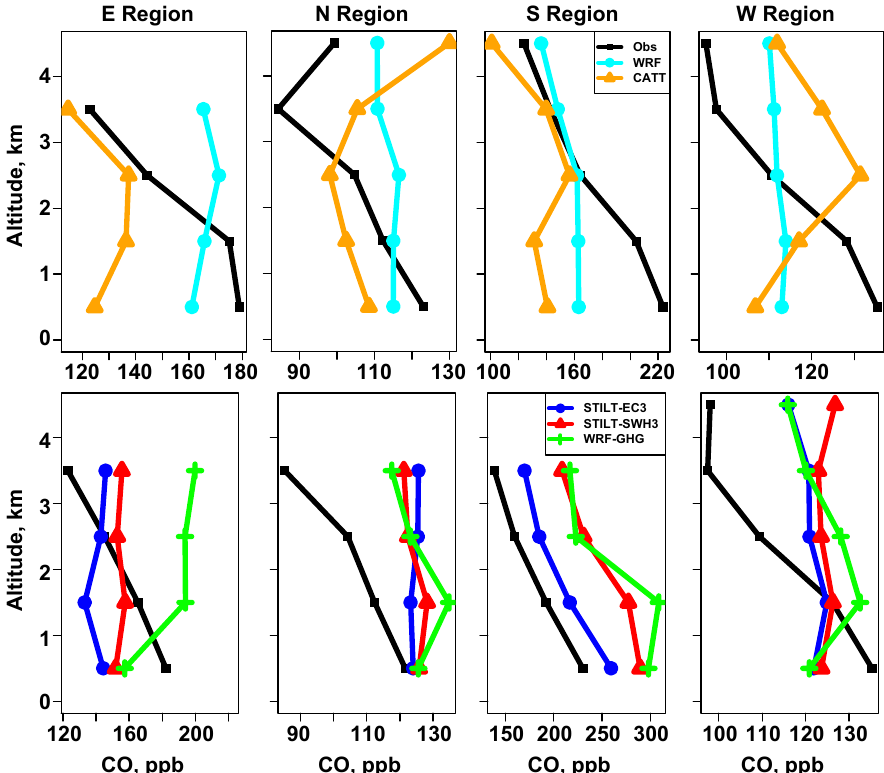
Fig. 12. Vertical profiles (regional medians, 1000m blocks) for CO for high resolution models, compared to observations. Data are disaggre- gated by region (E and W of Manaus, within 4 ◦ of the Equator, and N and S of Manaus, roughly on the 60 ◦ W meridian; the region influenced by Manaus was excluded.) The upper panel shows the INPE model results (CATT-BRAMS and WRF-Chem). The lower panel shows the Jena models (the STILT Lagrangian framework with two different assimilated meteorological fields, and one Eulerian WRF model), all with CO treated as a passive tracer. Data acquired in areas influenced by local pollution (e.g., near airports and in localized smoke plumes) were excluded, comprising ∼ 15% of data points. Differences in observed values between upper and lower panels are the result of different averaging procedures required to match the observations to the model